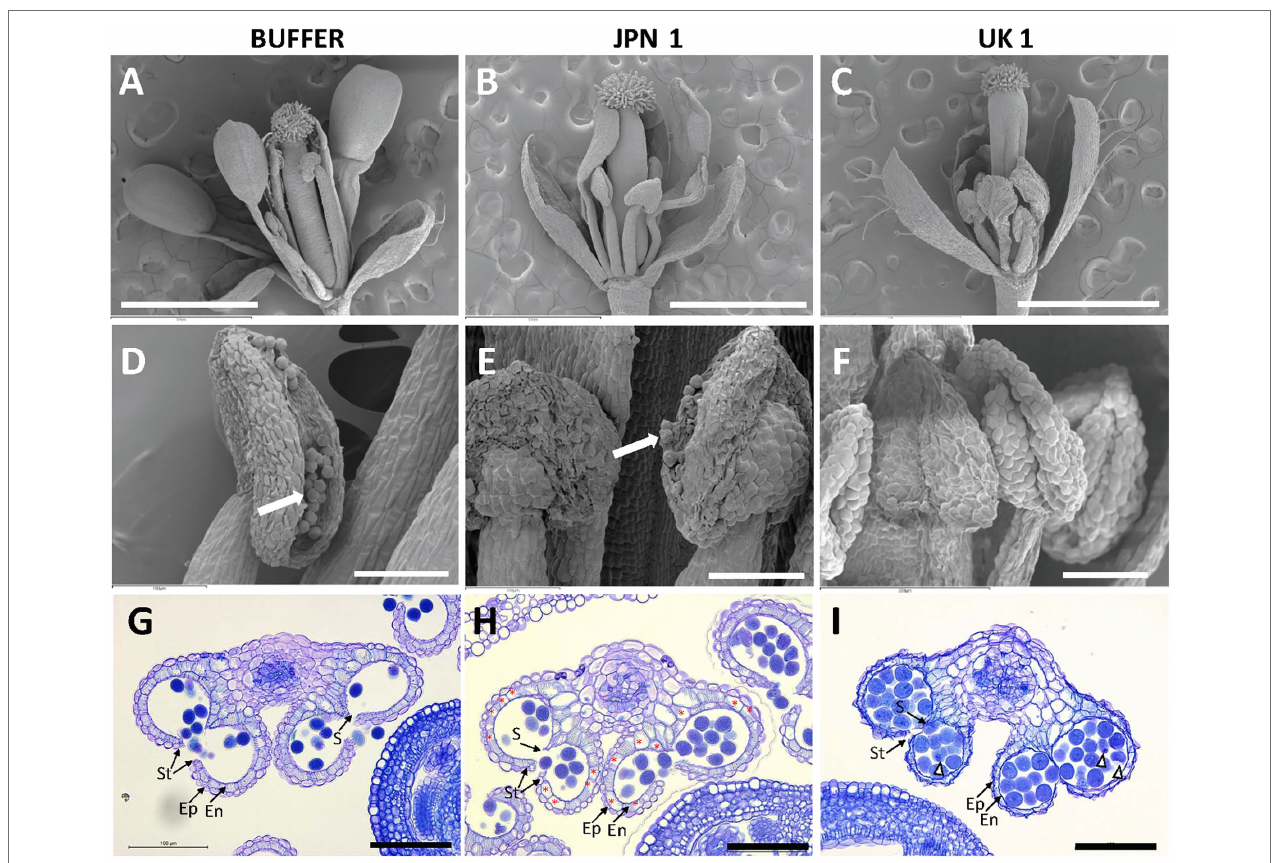
FIGURE 7 | Phenotypes of flowers from control buffer-inoculated and two strains of TuMV-infected Arabidopsis plants. Scanning electron micrographs of flowers at anthesis (A-C) and flower anthers (D-F) . Pollen grains are visible in D and E (arrows). Transversal sections of anthers from flowers at anthesis stained with toluidine blue (G-I) . Non-infected mock plants show strong lignification of the endothecium. Endothecium cells showing absence of lignification are marked by asterisks in H . Abnormal pollen grains are marked by arrow heads. Scale bars indicate: 1 mm in A-C and 100 μ m in D-I . Epidermis (Ep); endothecium (En); stomium (St); and septum